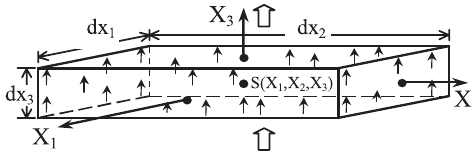
Fig. 7. Water diffusion in a volume element dx 1 . dx 2 . dx 3